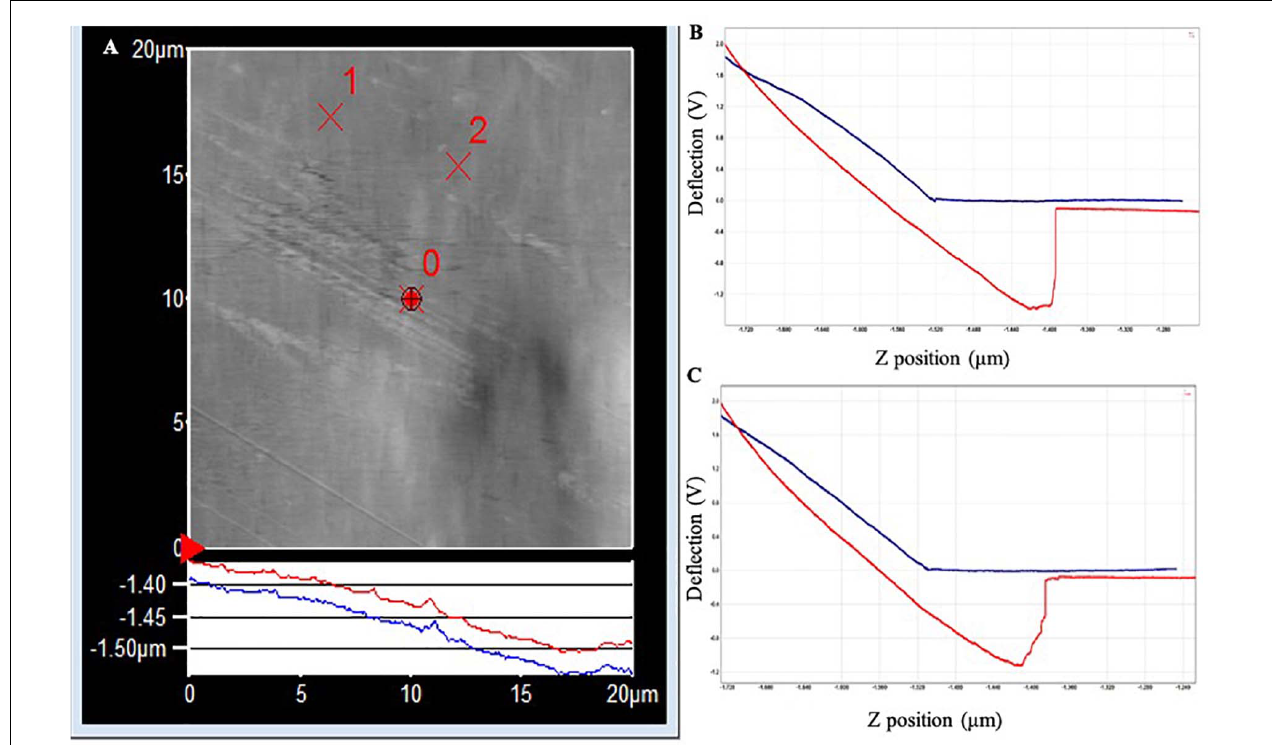
FIGURE 3 | (A) AFM topography image of the PET surface (20 × 20 µ m) following exposure to Standard Seawater for 24 h. The force curves were acquired at the locations identified as × 1 and × 2, which did not have any apparent surface abnormalities. (B) Force–distance curve acquired at location × 1. (C) Force–distance curve acquired at location ×